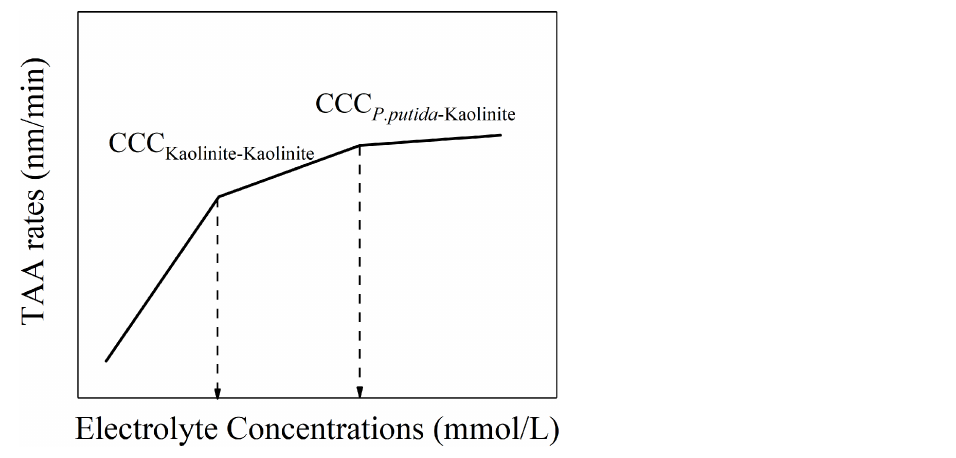
Figure 6 Schematic diagram of ‘‘kaolinite- P. putida ’’ TAA rates as a function of electrolyte concentra- tion.